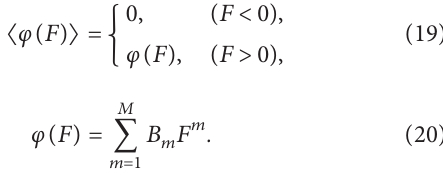
Figure 8: Three-dimensional viscoelastic fatigue model.